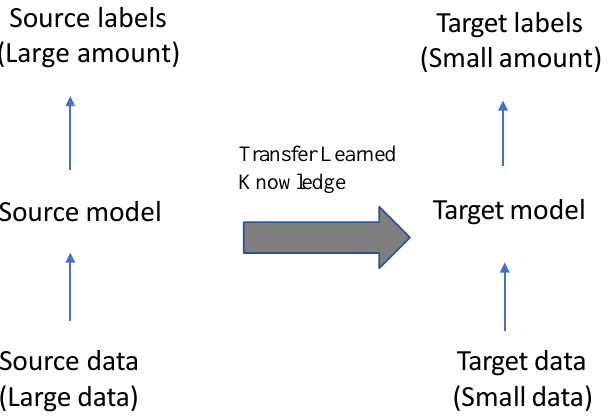
Figure 6. The concept of transfer